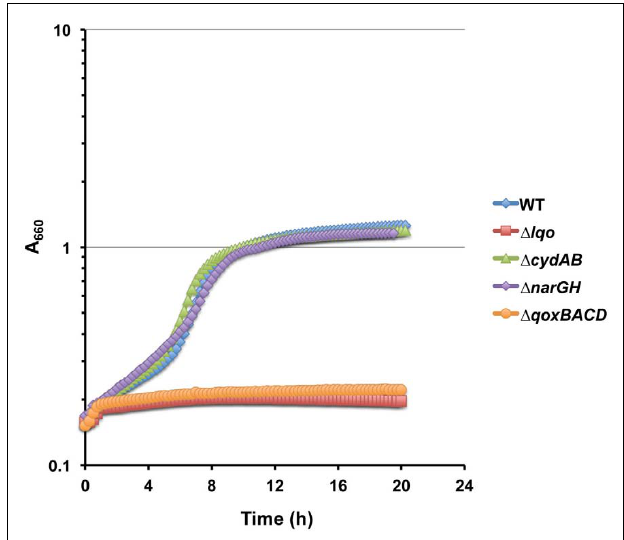
FIGUREA6 | Cytochrome- aa 3 (QoxBACD) is required for Lqo activity during NO · -stress. Representative growth curve onWT S. aureus strain COL and isogenic mutants grown in chemically defined medium using a combination of 0.1% L-lactate/1.0% tryptone as primary carbon sources in the presence of low level NO · (administered as 10mM DETA/NO when cultures reach A 660 =